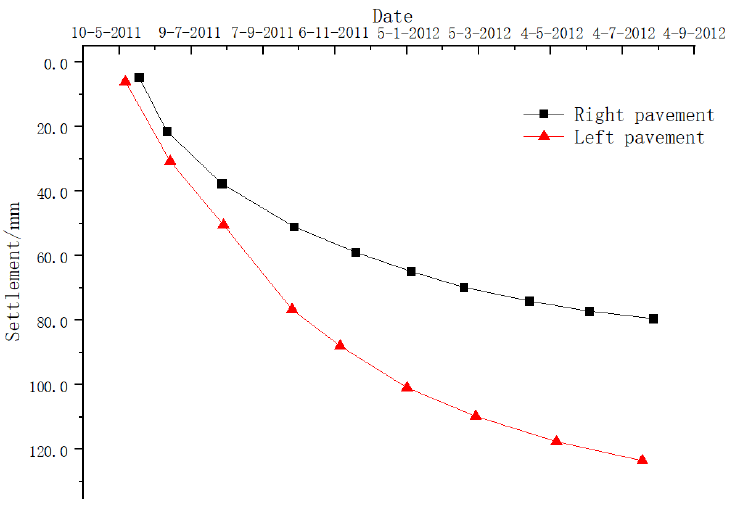
Figure 5. Total embankment settlement after improvement with